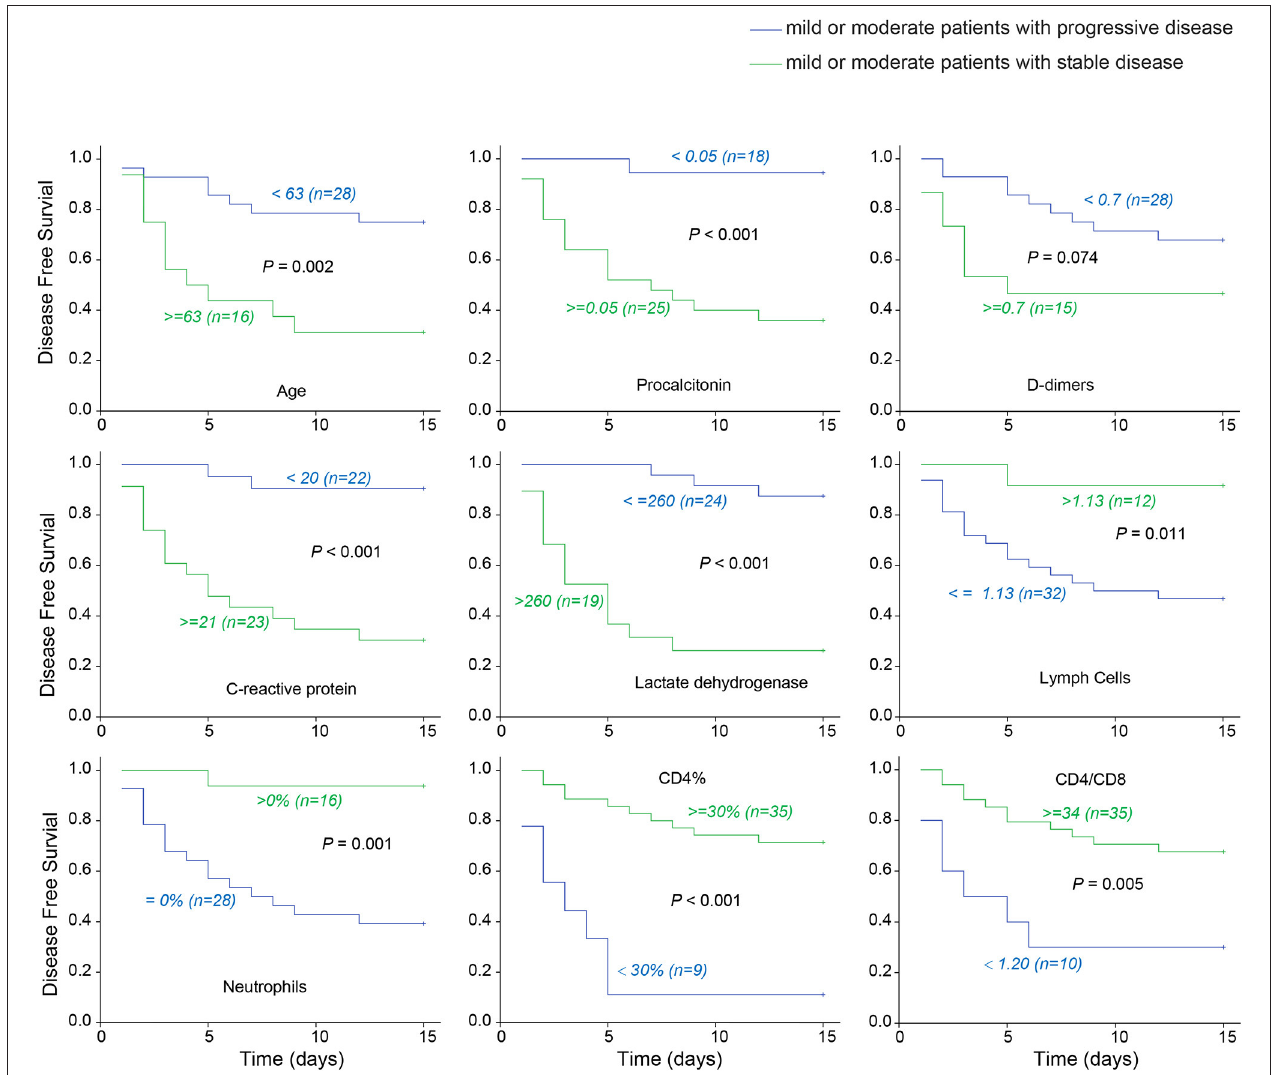
FIGURE 1 | COVID-19 early warning indicator survival curve. The associations between severe disease free survival and early indicators in 43 patients with mild or moderate disease upon admission. Taking hospitalization to become severe as the end, the latest turn weight is 12 days, and the longest stable condition is 15 days. The optimal cut-points are selected for discriminating the patients to high or low risk who will develop severe disease using Maxstat software. Lactate dehydrogenase and procalcitonin etc. are early warning indicators to severe